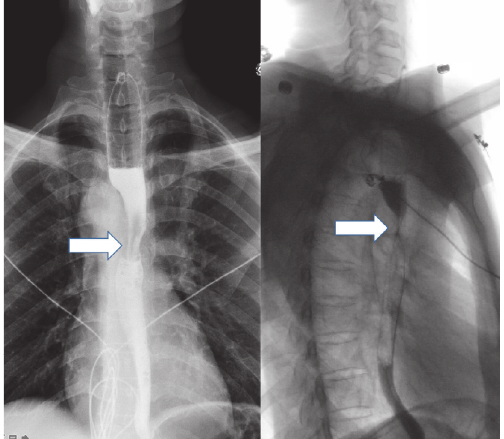
Figure 2: Preoperative barium esophagogram posteroanterior view and lateral view depicting fixed esophageal narrowing at the level of T6 (arrows).